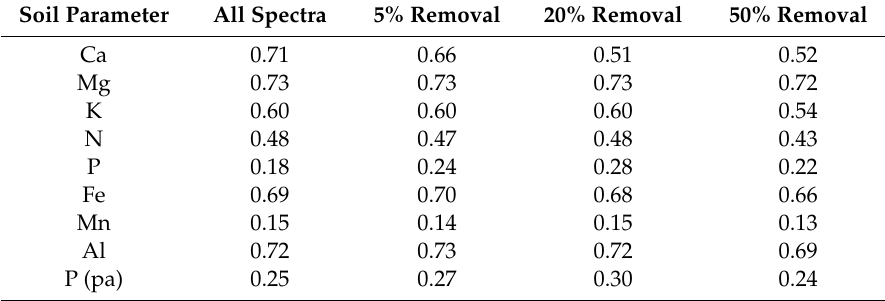
Table 3. E ff ect of outlier elimination based on the Euclidean distance of a data point to the center of the principal component space, comparison of coe ffi cients of determination for